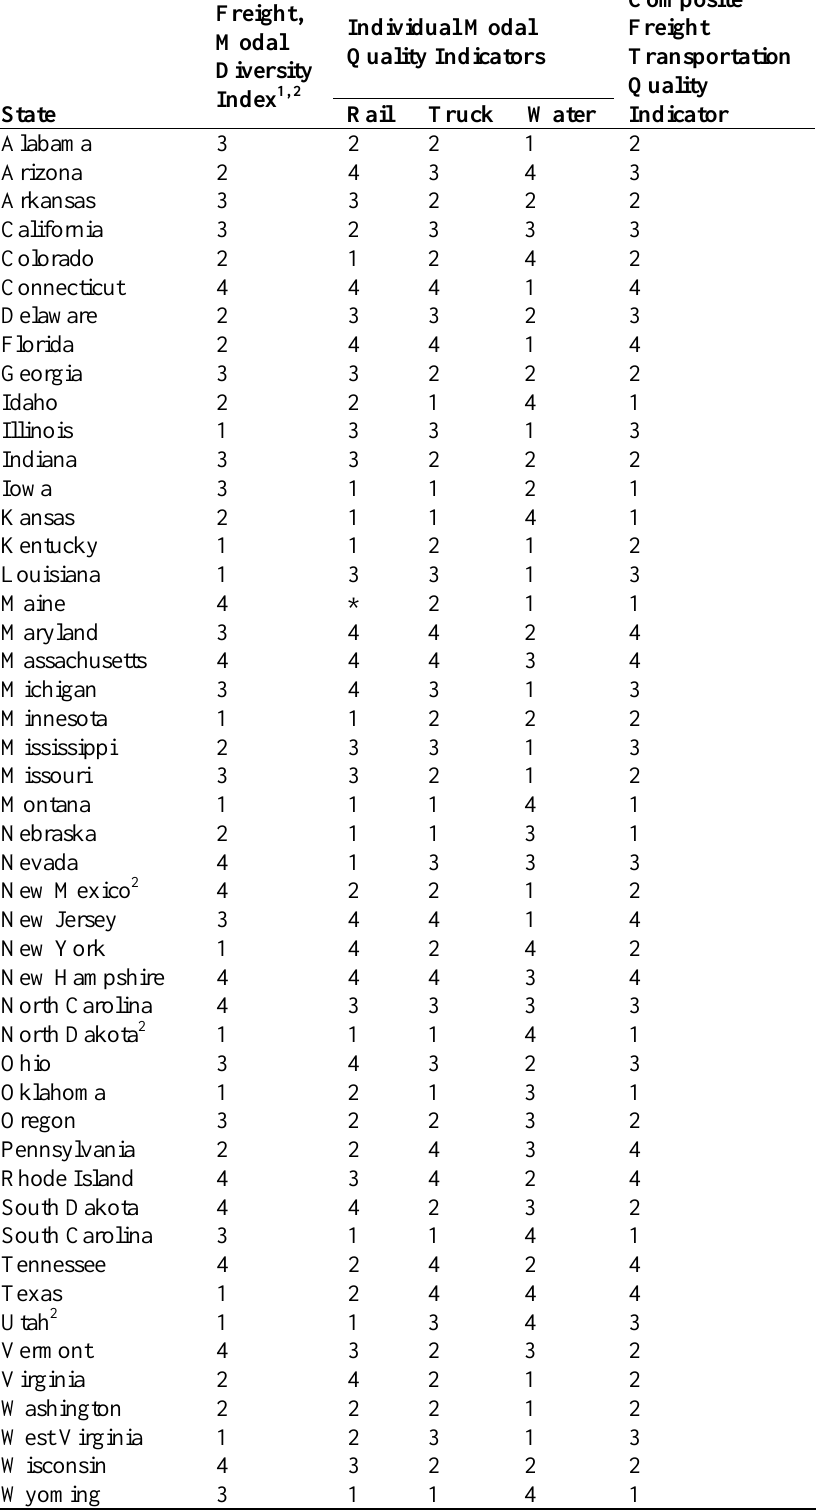
Table 2. Freight transportation diversity and quality indicators (Quality Quartile: 1 = more positive to 4 = more negative for overall